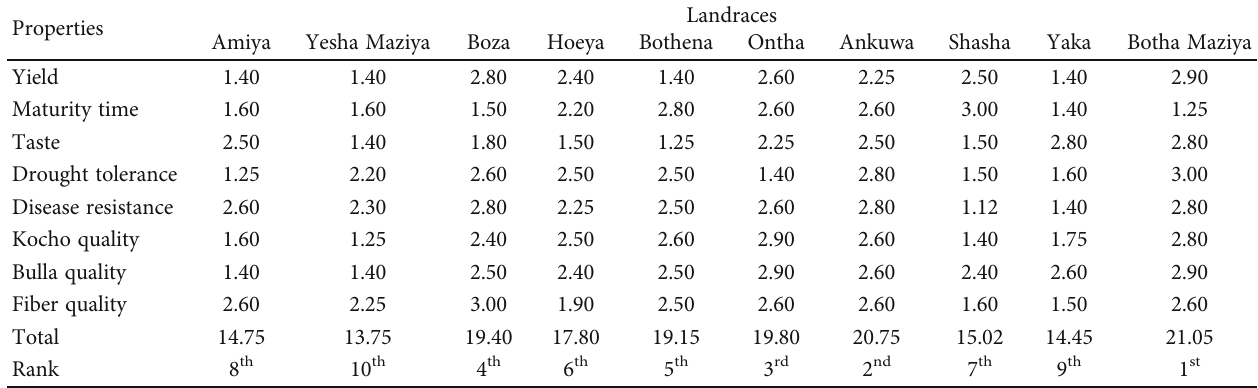
Table 6: A direct matrix ranking of ten Mareka district landraces against eight properties, with three indicating the best, two indicating the medium, and one indicating the worst.